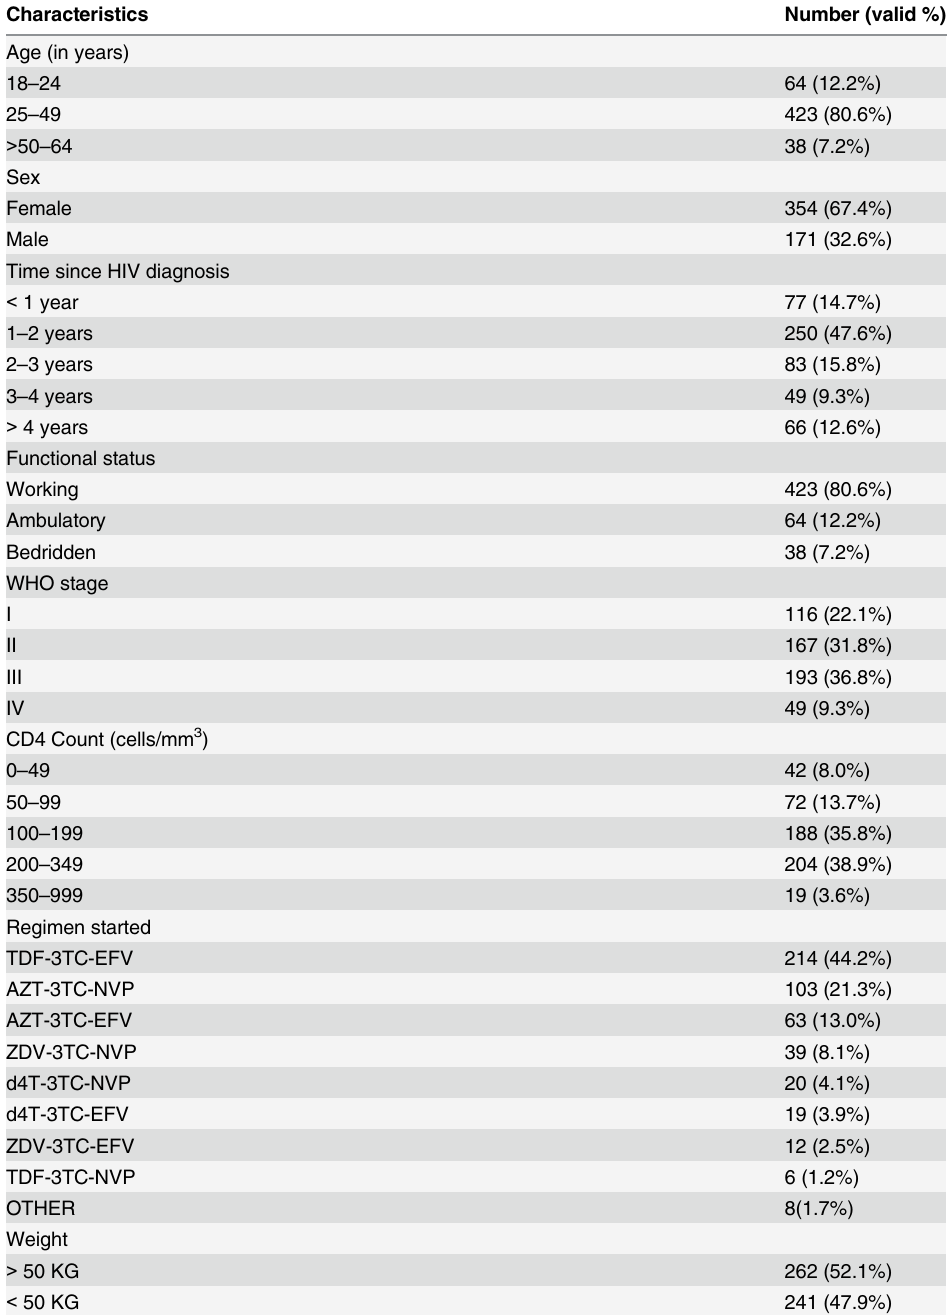
Table 1. Socio demographic and clinical characteristics of ART patients in private health facilities in Addis Ababa, 2009 –